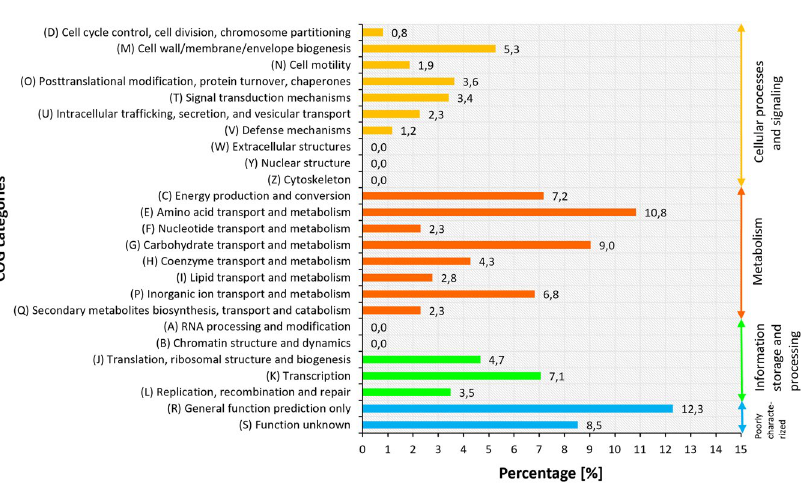
Figure 2. COG analysis of Enterobacter aerogenes LU2. Colored bars indicate the percentage of genes assigned to each COG